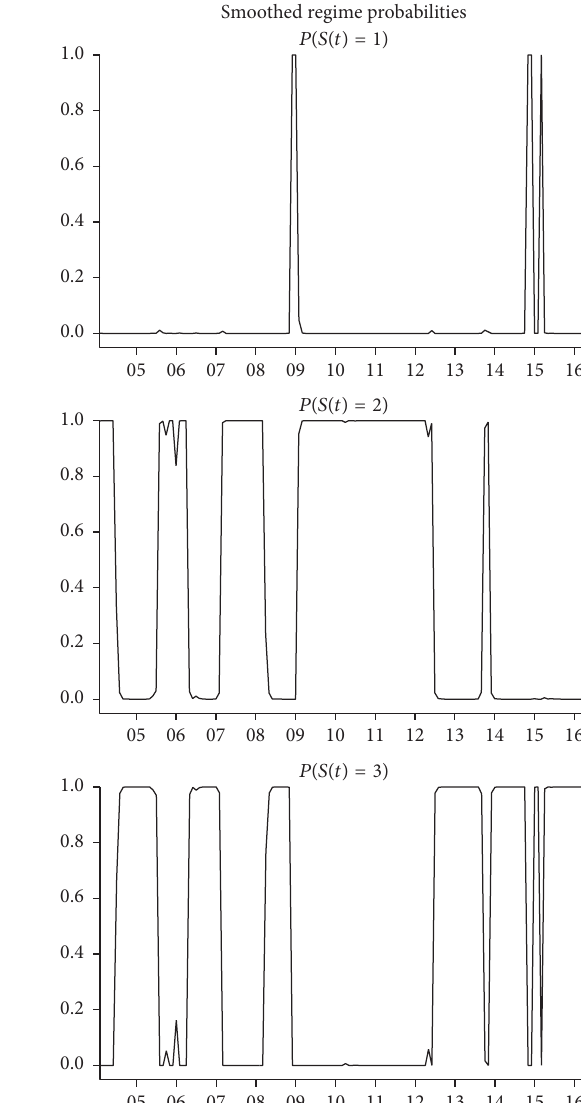
Figure 5: Time and smoothed probability plots of USD/JPY for 2004M01–2016M05.